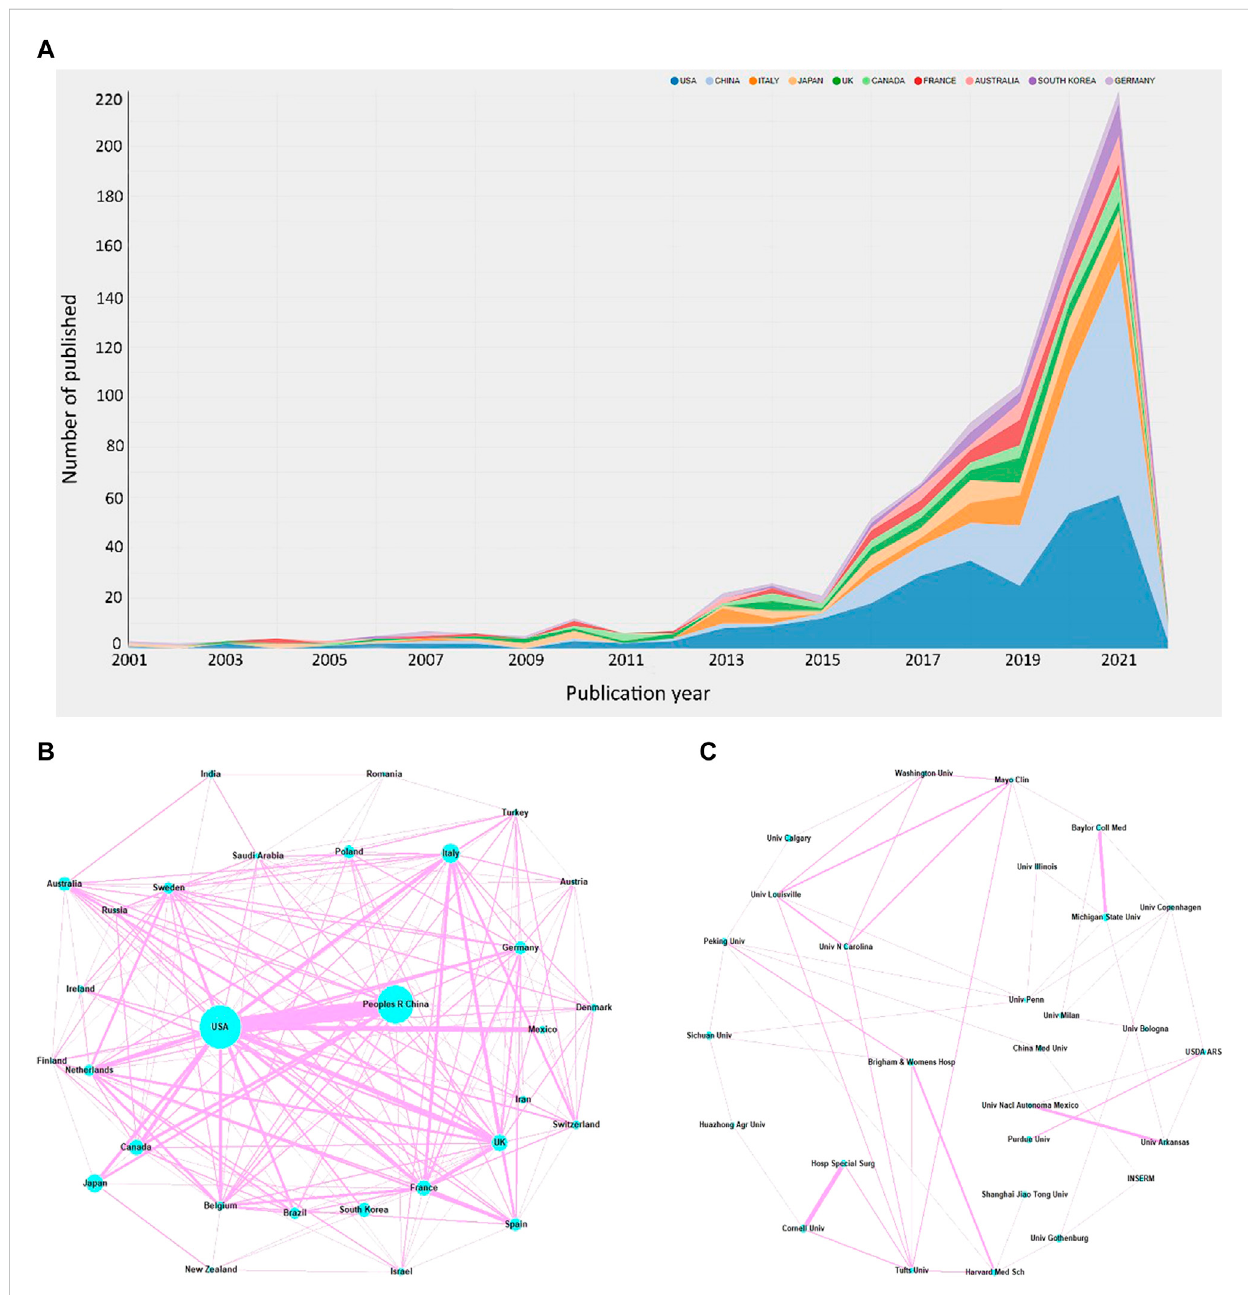
FIGURE 2 (A) Number of publications and increasing trend in the top 10 countries. The network of the cooperation between the top 30 countries (B) and top 30 institutions (C)